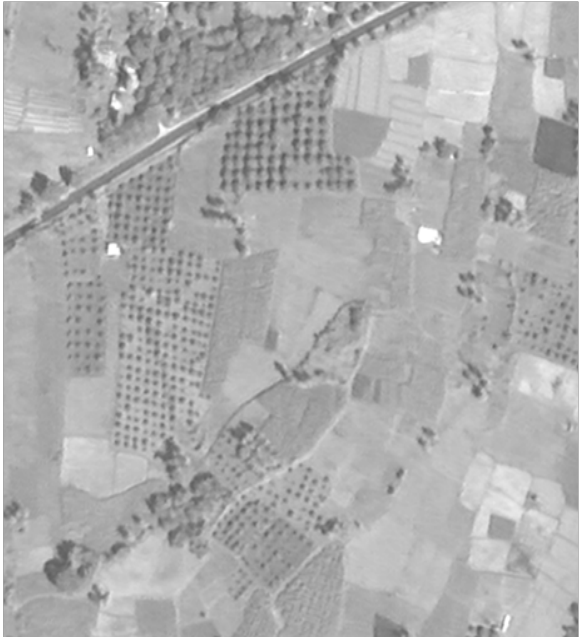
Figure 4. Input Image of Chittoor region